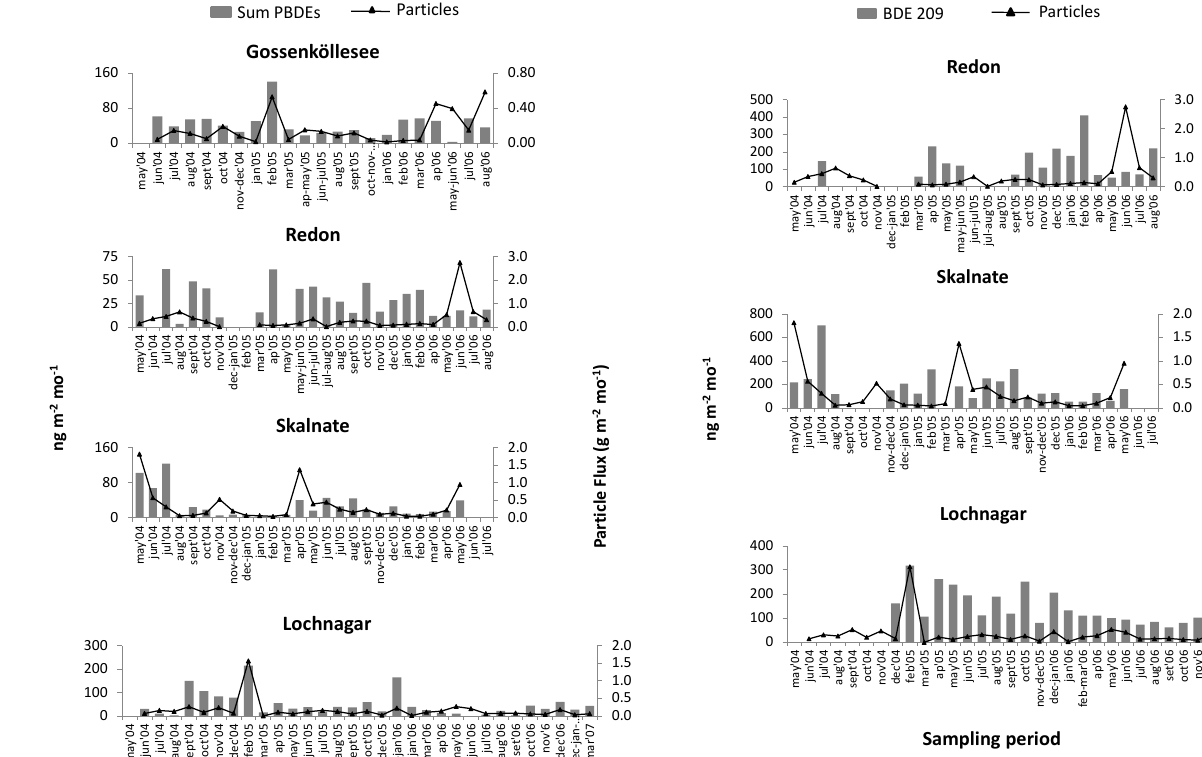
Fig. 3. Temporal variation of particle (straight line) and BDE209 de- position fluxes to the studied sites. Data from Gossenköllesee pre- cluded due to the large number of samples with levels below the detection